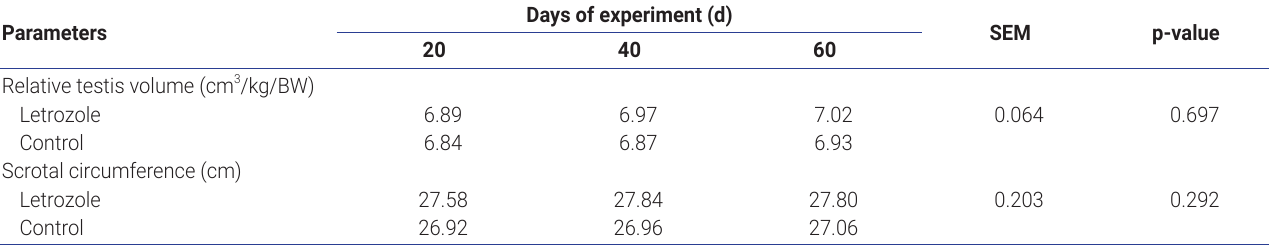
Table 1. Testicular biometric parameters in Markhoz bucks treated letrozole (0.25 mg/kg BW/wk) or control Parameters